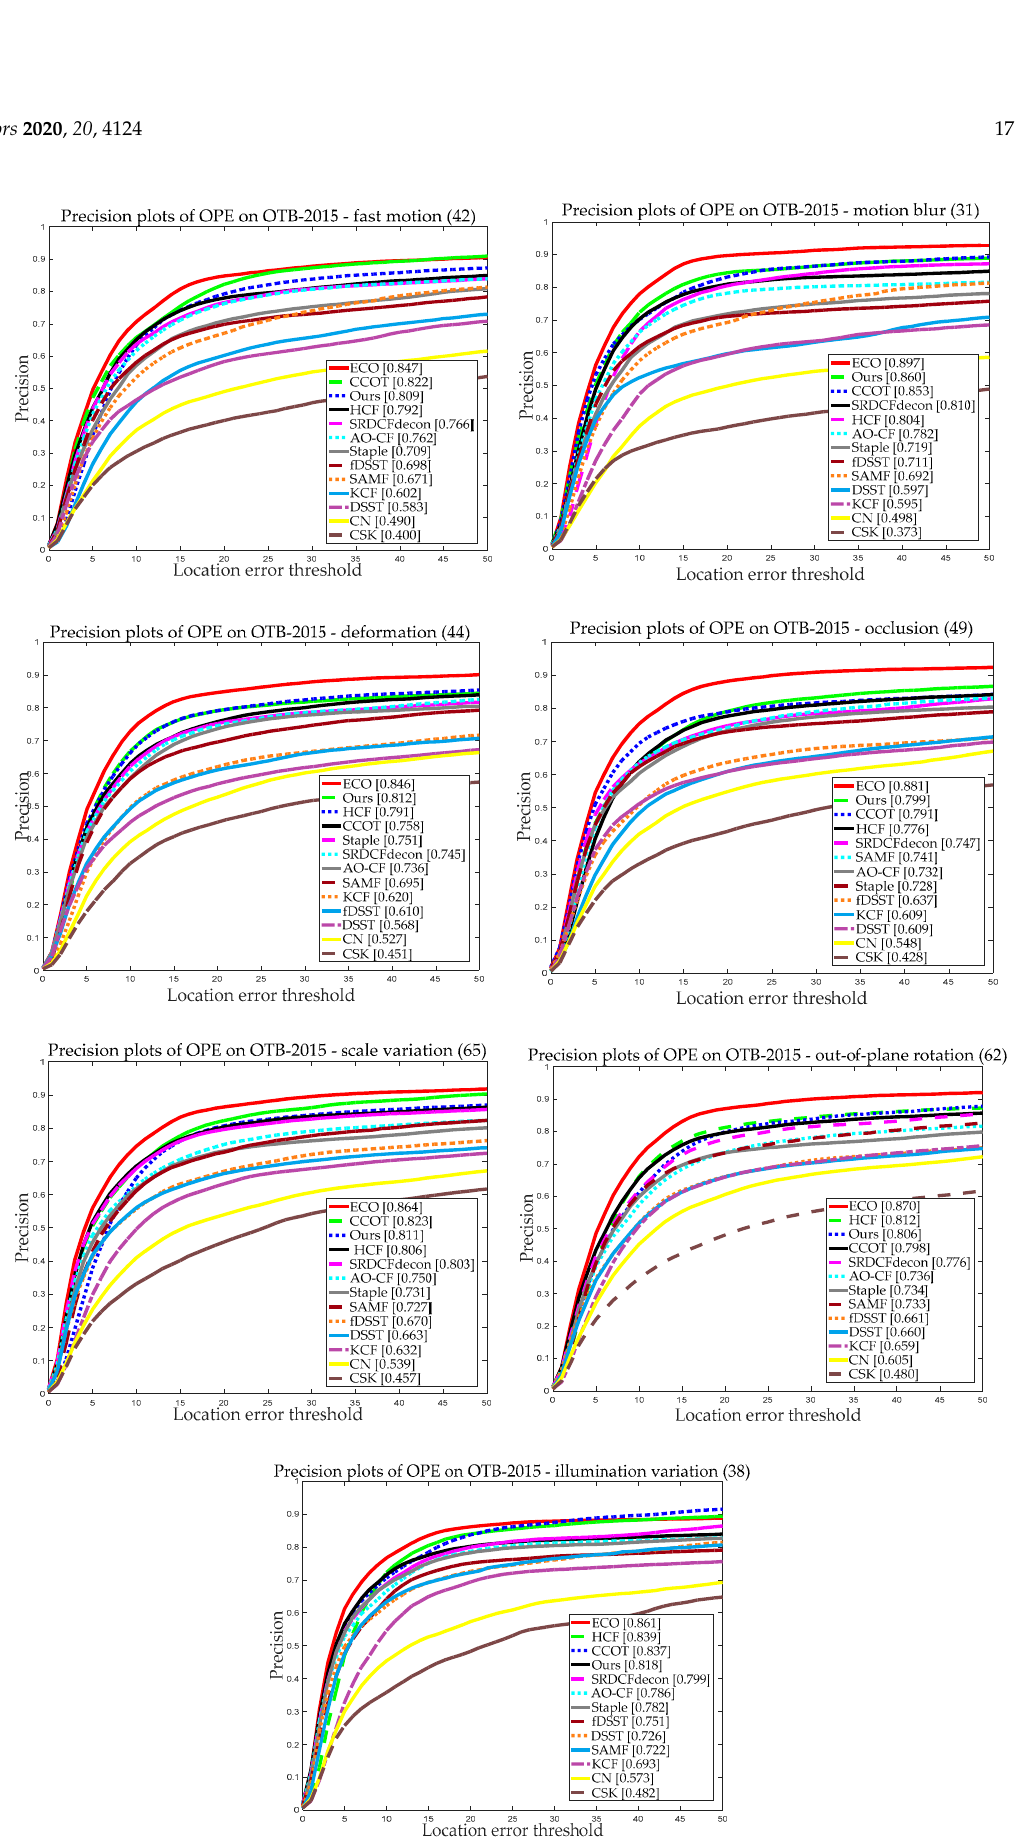
Figure 9. Precision plots for the compared trackers on OTB ‐ 2015 with 11 attributes using OPE.